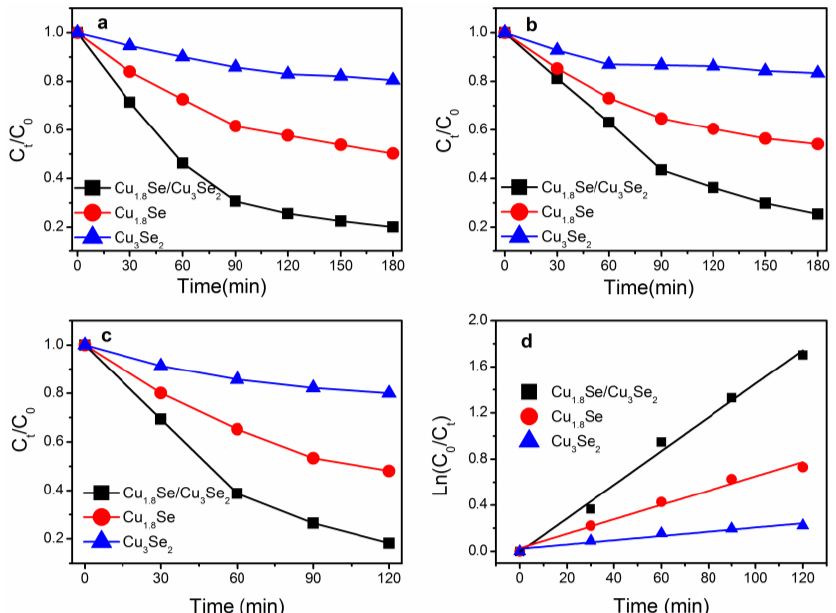
Figure 4. Photocatalytic degradation of methyl orange (MO) solution with copper selenides as catalysts under ( a ) visible light; ( b ) NIR light; ( c ) full solar light; ( d ) the degradation kinetics by means of plotting ln( C 0 / C t ) versus time.